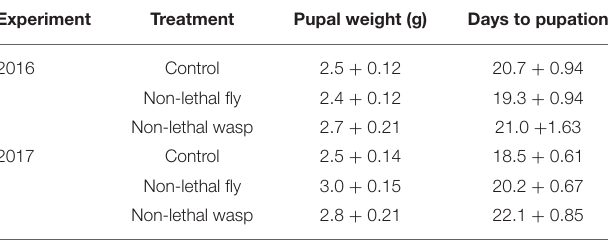
TABLE 1 | Weight at pupation (g) ± SE and days to pupation ± SE for larvae surviving to pupation in the 2016 (top) and 2017 (bottom) experiments.